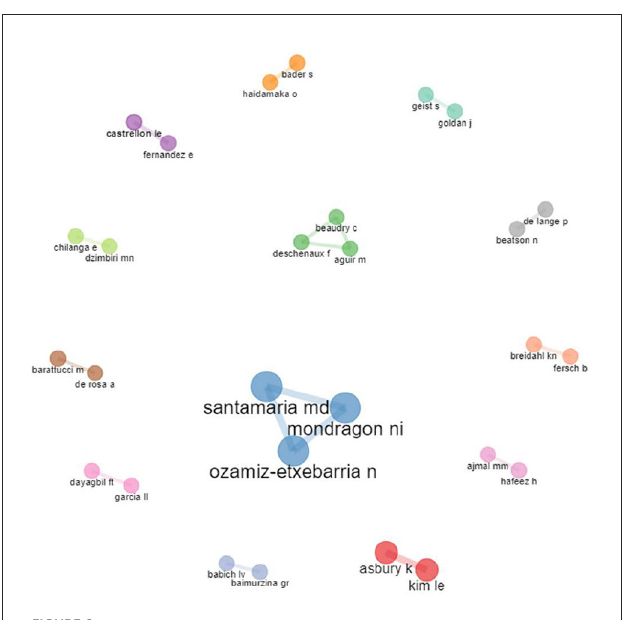
FIGURE6 Co-authorship networks ( ≥ 1